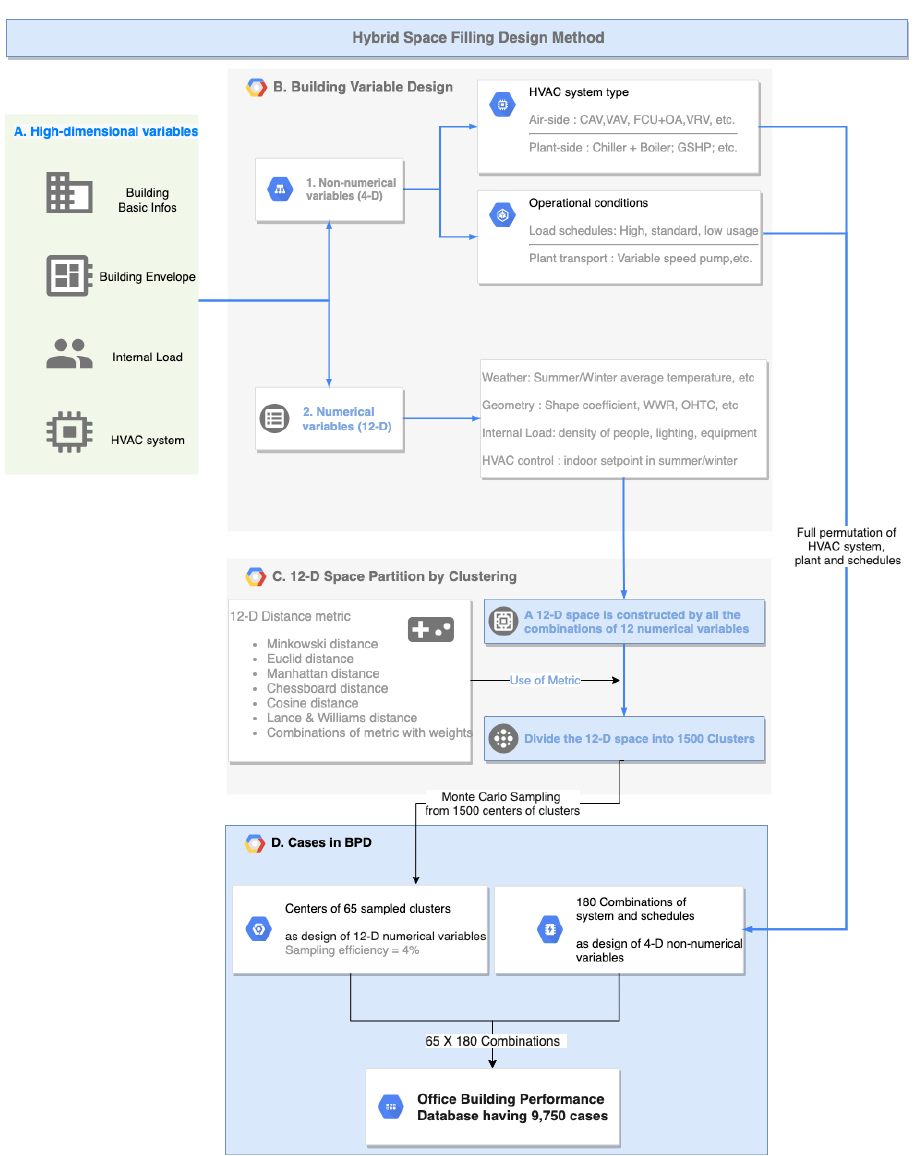
Figure A1. Hybrid space filling design method for case design of BPD in [22].